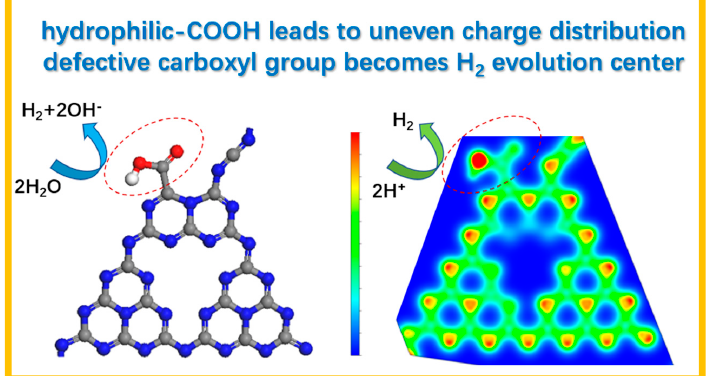
Figure 8. Schematic diagram of the dual-enhancement mechanism of structural carboxyl defect sites on the promoted H 2 production activity of g-C 3 N 4 . Left: structure diagrams of defective carboxyl site with hydrophilic properties facilitating the H 2 O to H 2 reaction; right: corresponding charge distri- bution map with electron-rich site facilitating the H + to H 2 reaction.